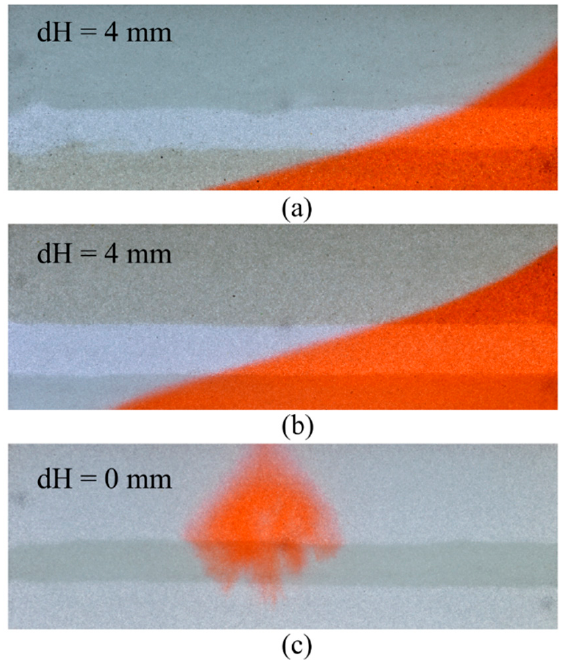
Figure 2. Photos of laboratory-induced saline intrusion in the three stratified aquifers. Experiment 1: saline wedge intruding into ( a ) Layered1 and ( b ) Layered2 aquifers, 20 min after the hydraulic head difference was changed from 6 to 4 mm. Experiment 2: the saline plume, 3 min after its introduction to the ( c ) Layered3 aquifer, while no head difference is applied between the left and right side tanks.